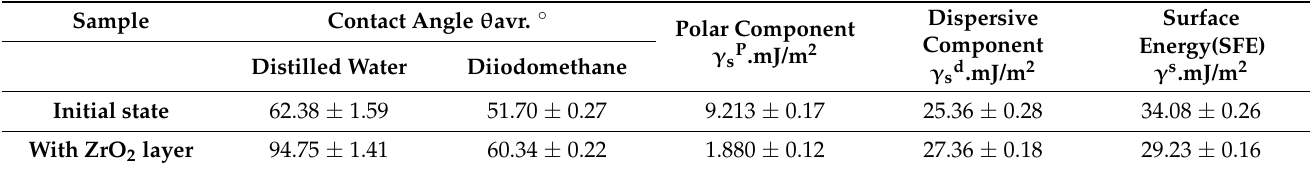
Table 4. Wettability and surface free energy results.